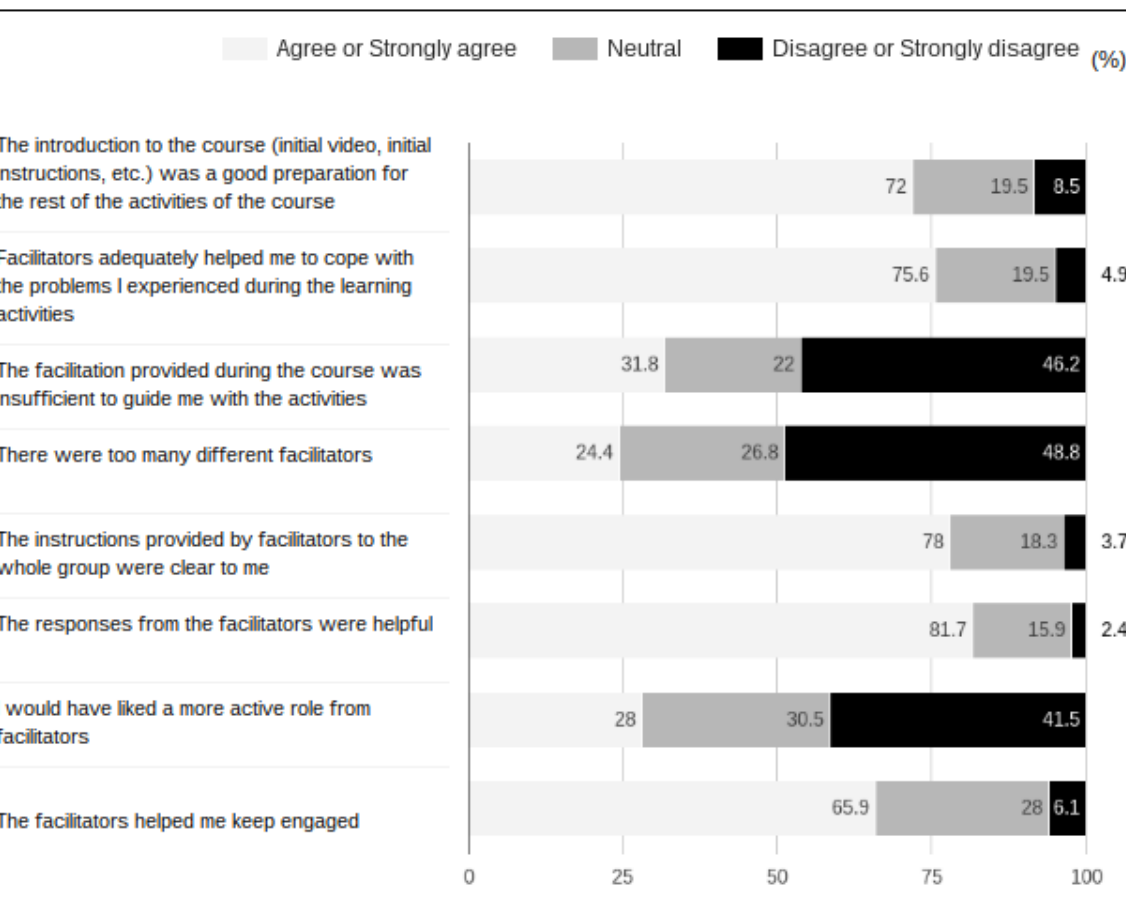
Figure 12 . Results of the survey of the participants about